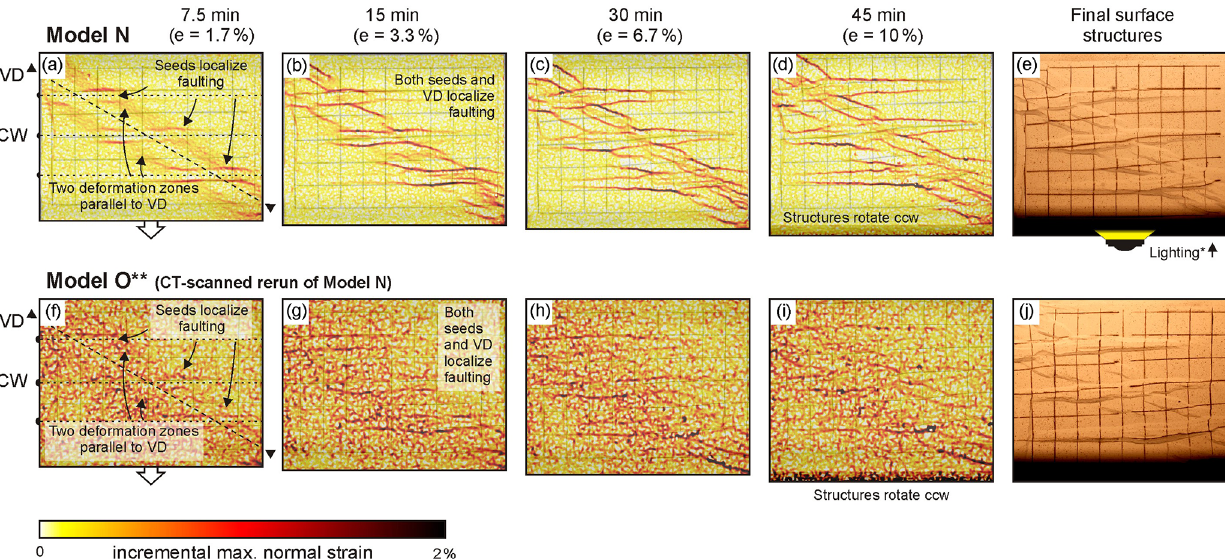
Figure 9. Incremental maximum normal strain maps of models N and O from Sub-series 2.3 (with 30 ◦ oblique VD, model axis-parallel weaknesses in the brittle cover and a double extension velocity of 40mm/h; compare to reference models G and H, Fig. 5a–j) obtained through PIV analysis, taken as a proxy of fault activity. The increments for PIV analysis were 1min, i.e. every 0.33mm of extension. The original models map-view pictures are visible in the background. The right-hand column depicts the model surface at the end of each experiment. VD: velocity discontinuity. CW: (simulated) crustal weakness. ccw: counter-clockwise. ∗ Shadows cast by one-sided lighting allowing a better visualization of the final surface structures. ∗∗ Due to technical issues, the PIV analysis of Model O is less detailed.